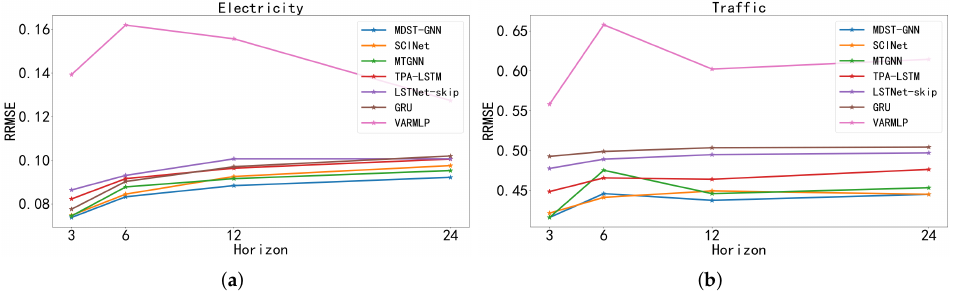
Figure 9. RRMSE comparison of all methods in Electricity and Traffic. Left ( a ) is the RRMSE result of all methods in Electricity, right ( b ) is the RRMSE result of all methods in Traffic, and horizon takes 3, 6, 12, and 24